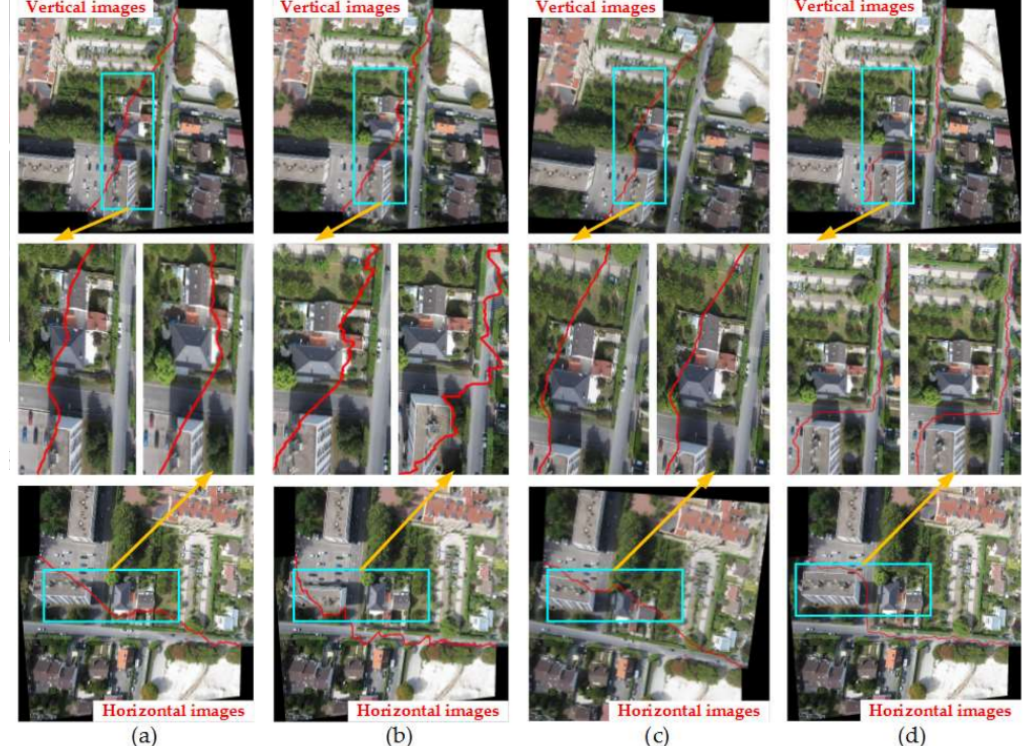
Figure 12. The seam-lines of four search methods for Figure 7a: ( a ) Dulapquet3-DP; ( b ) Dulapquet4-DP; ( c ) OpenCV-DP; ( d )